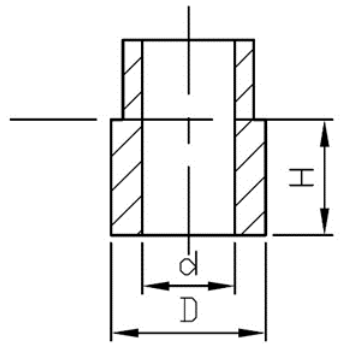
Figure 2. Technical drawing of molded test samples for tensile strength measurements.